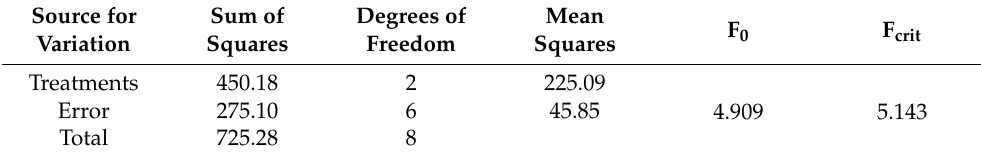
Table 6. The ANOVA results for the yield strength. Source for Sum of Variation